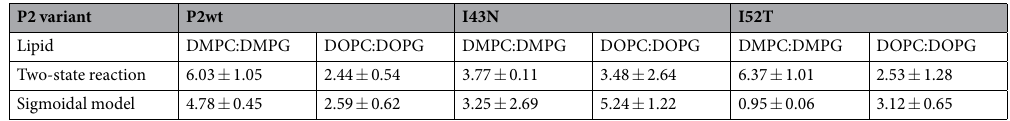
Table 3. Membrane surface affinity of P2 deduced from SPR data. The values are apparent K d in µ M, based on two separate